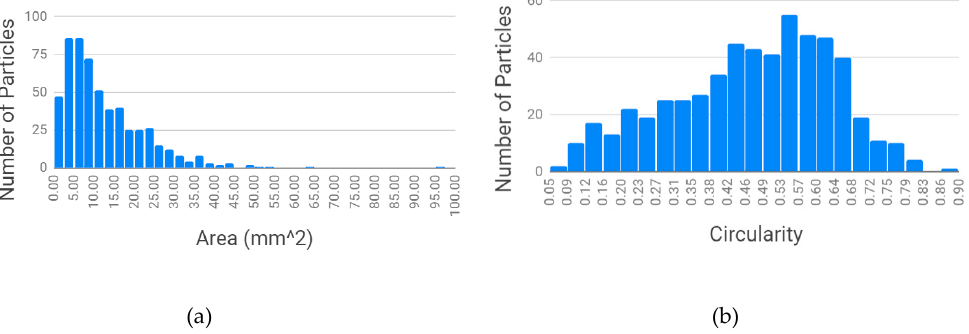
Figure 5. Houston-sourced PET water bottle flake: particle size distribution ( a ) and particle circularity ( b ).